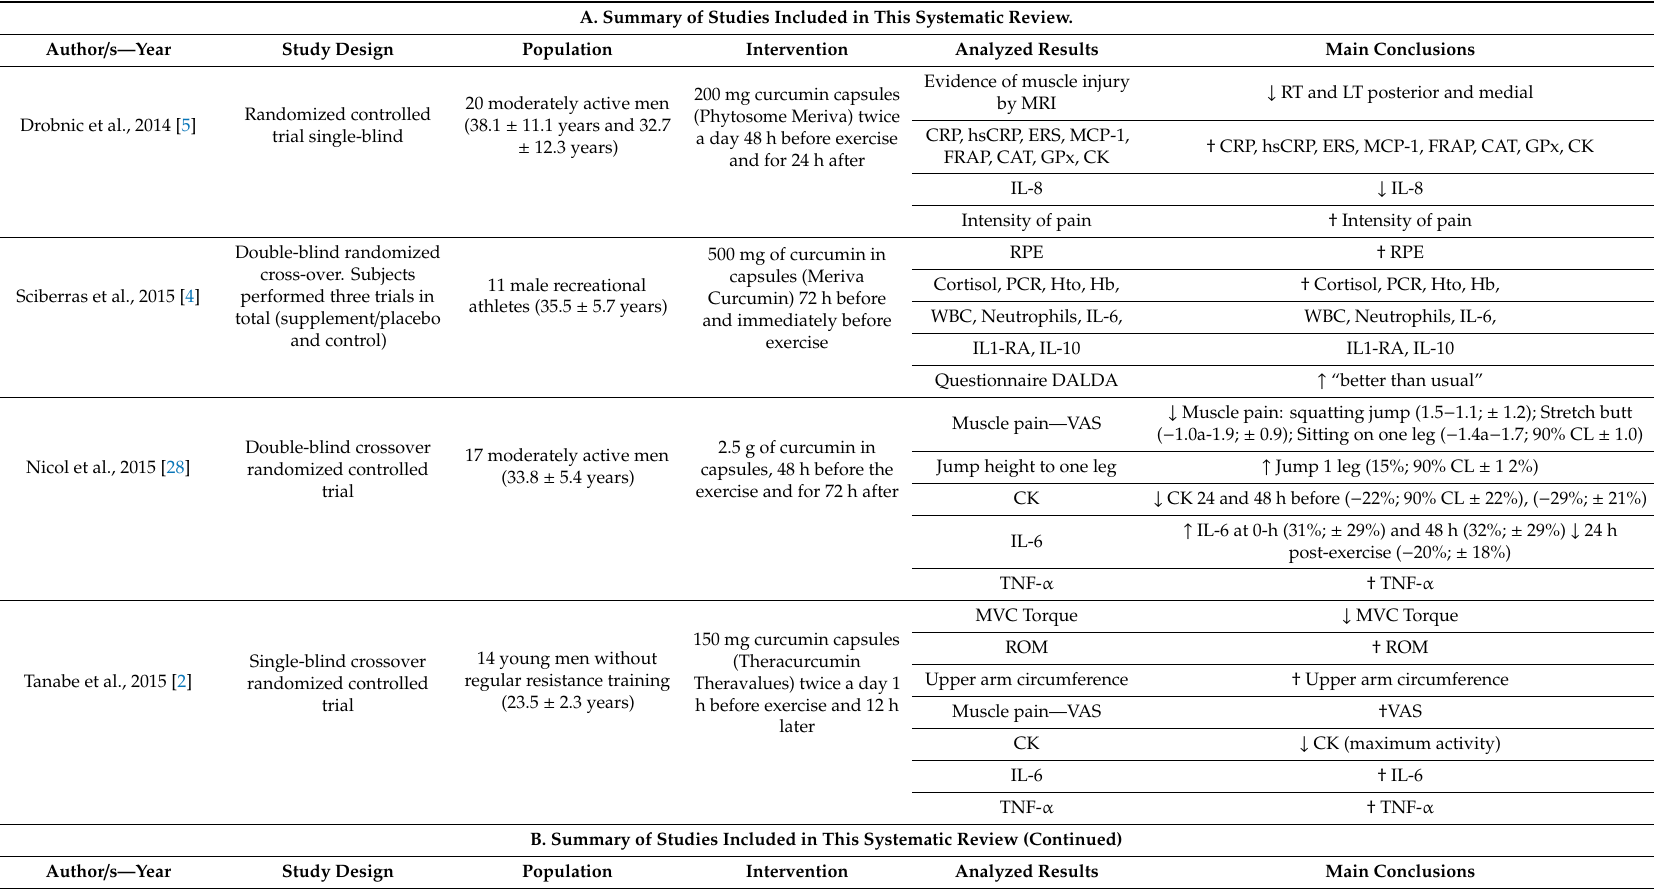
Table 3. Summary of studies included in this systematic review. A. Summary of Studies Included in This Systematic